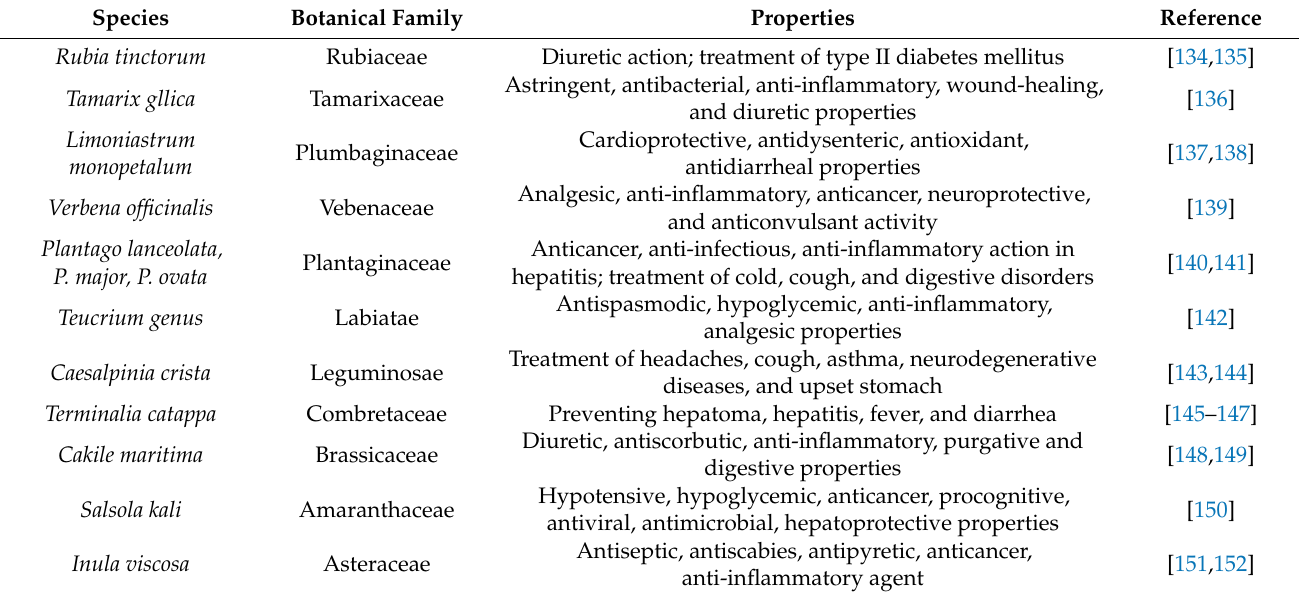
Table 3. Selected biological properties of